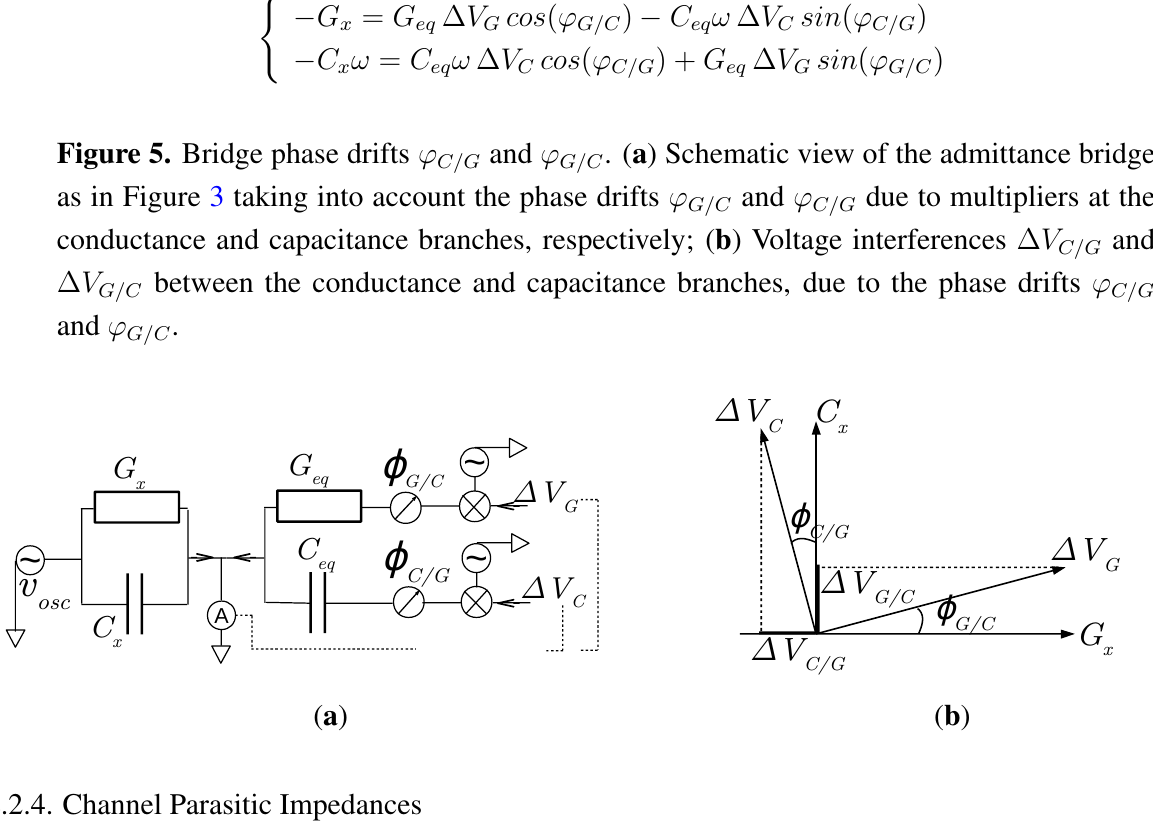
Figure 5. Bridge phase drifts ϕ